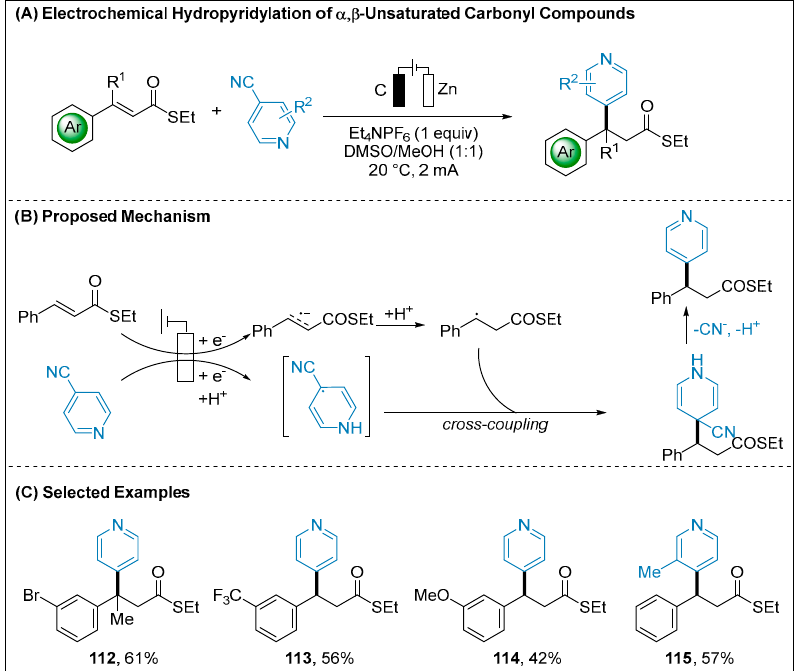
Figure 12. Electrochemical hydropyridylation of α , β - unsaturated carbonyl compounds.